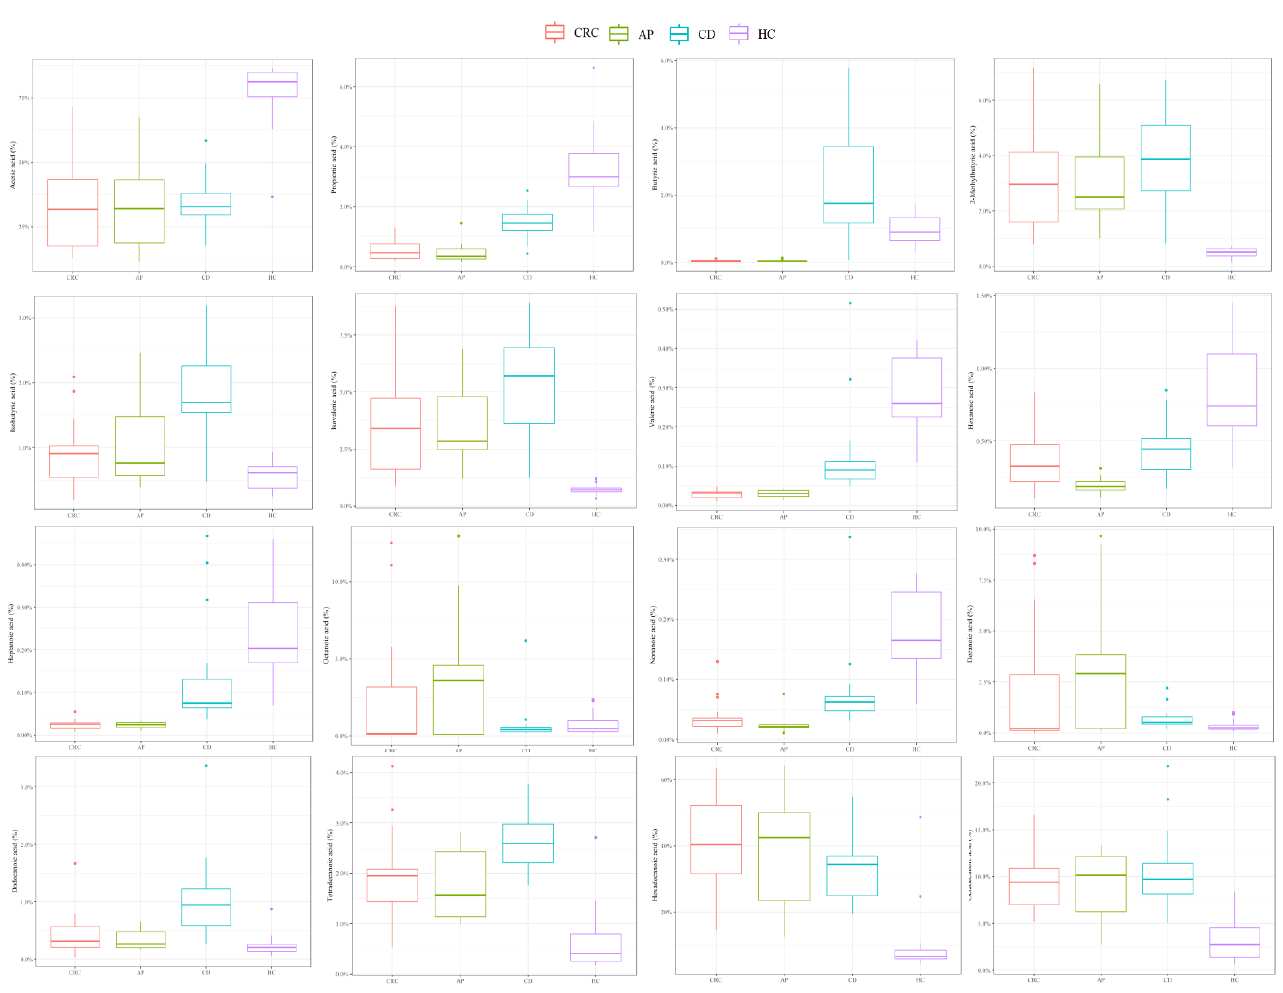
Figure 2. Boxplots representing each FFA percentage in CD, CRC, AP patients and HC. Table 3. p -values of the intergroup comparisons assessed with Wilcoxon tests conducted on FFA percentages. p -values less than 0.05 were considered statistically significant. FFA = free fatty acid;